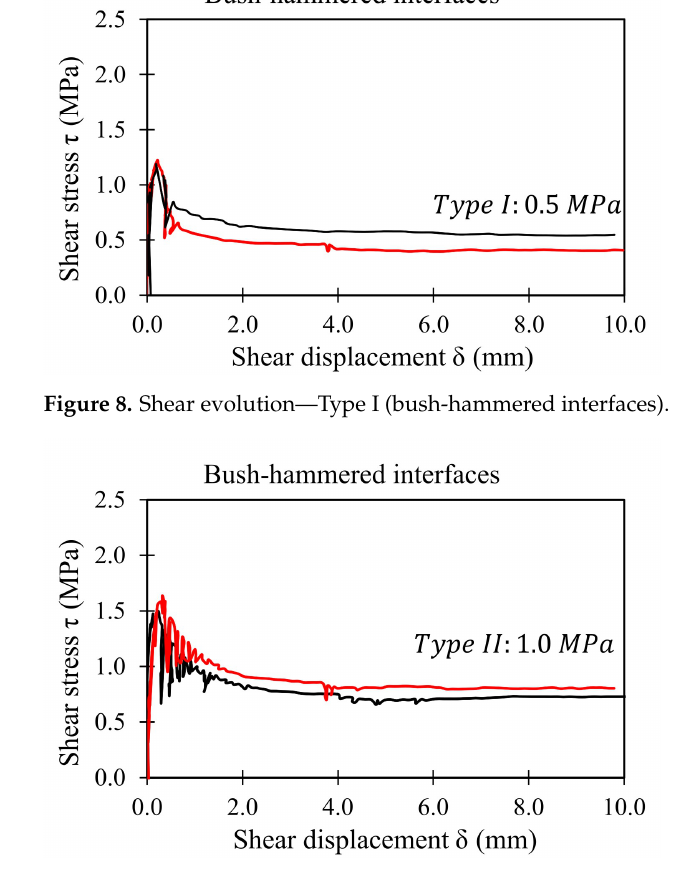
Figure 9. Shear evolution—Type II (bush-hammered interfaces).